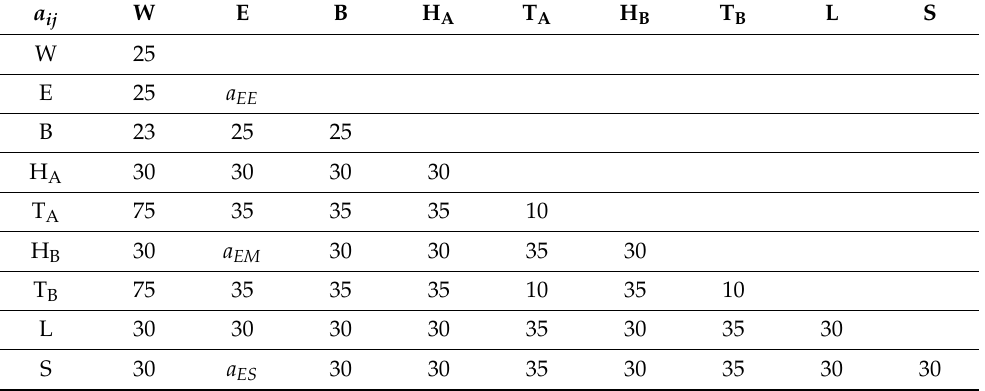
Table 1. Bead–bead conservative force parameters a ij (in units of k B T / d 0 ) for all bead types. The table is symmetric. The parameters a EE , a EM , and a ES specify the attraction between the IDP endcaps and themselves, the minority lipid headgroup, and the sticky domains in the linkers respectively as described in the